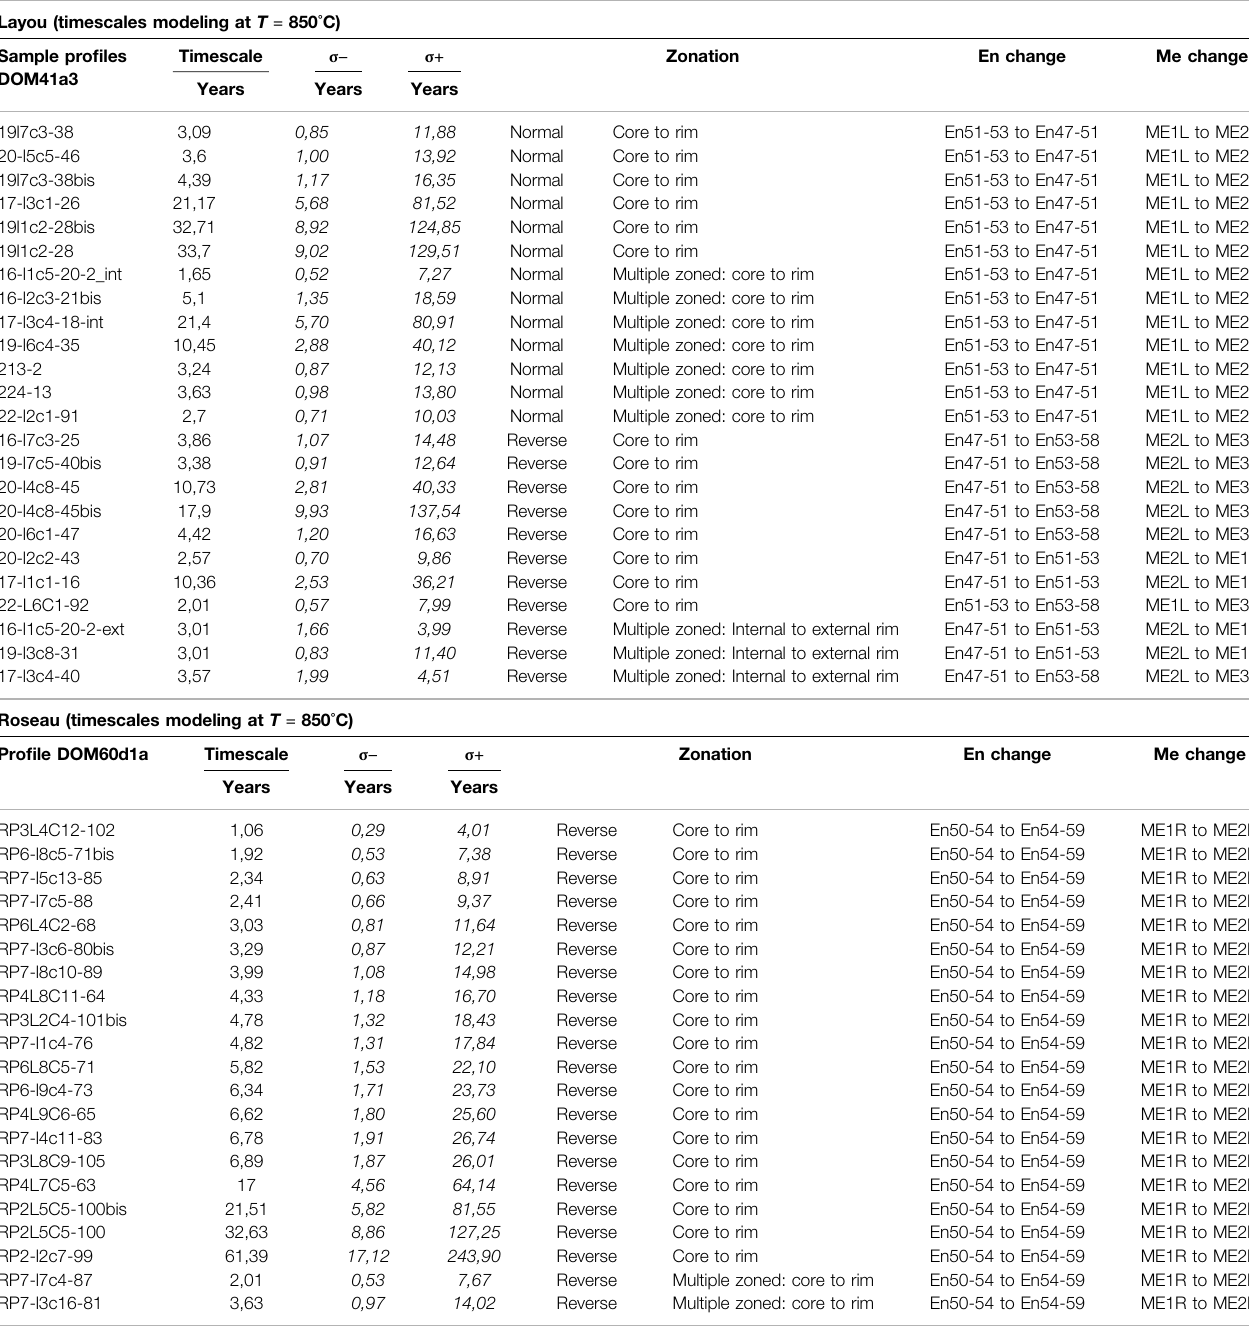
TABLE2| TimescalesestimatesforLayouandRoseaueruption.SamplelabelingreferstothestratigraphyofBoudonetal.(2017)withDOM41a3forLayouandDOM60d1a forRoseau.Timescalesaregiveninyearwiththedetailinuncertainty( σ +and σ − ).Thetypeofzonation(simpleormultiple)andthepositionwithinthemultiplezonedopxis given. The corresponding plateaus in En content and the ME changes are detailed. Layou (timescales modeling at T = 850 ° C) Sample pro fi les